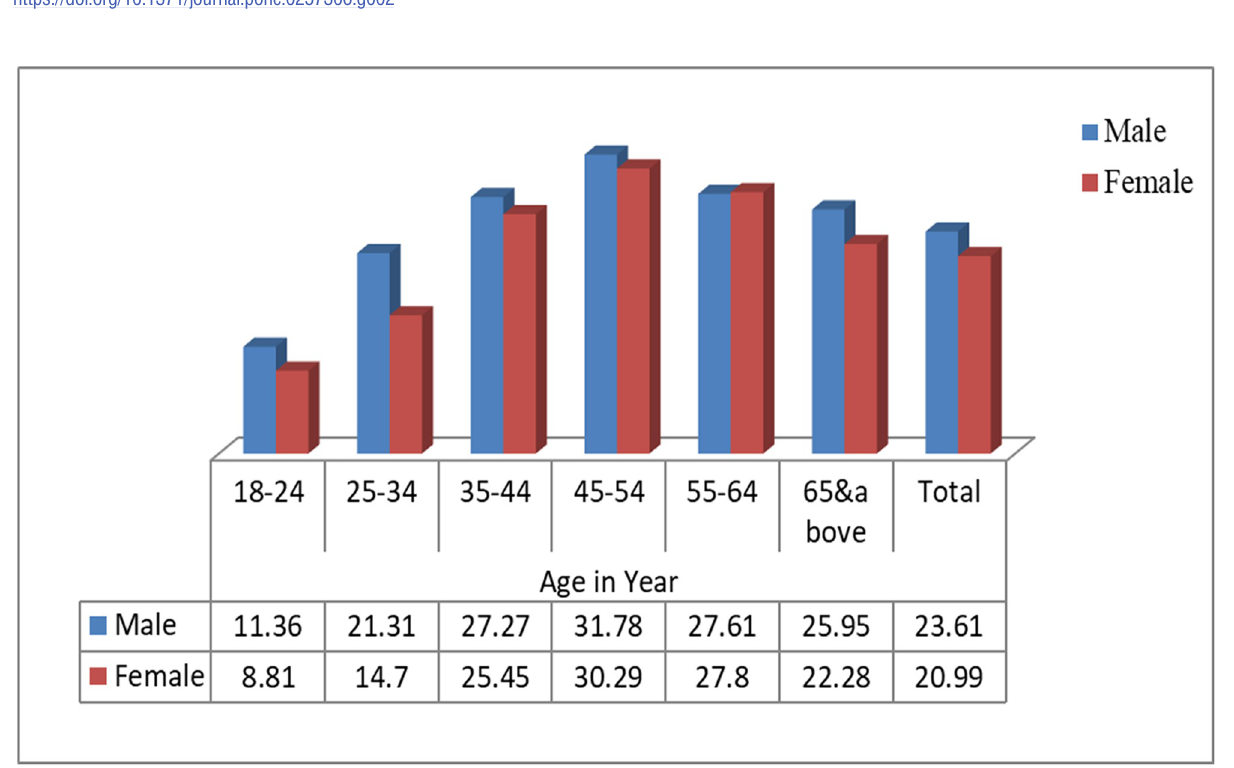
Fig 3. Distribution of high triglyceride level by age and sex among � 18 years old Gondar city residents, Northwest Ethiopia.